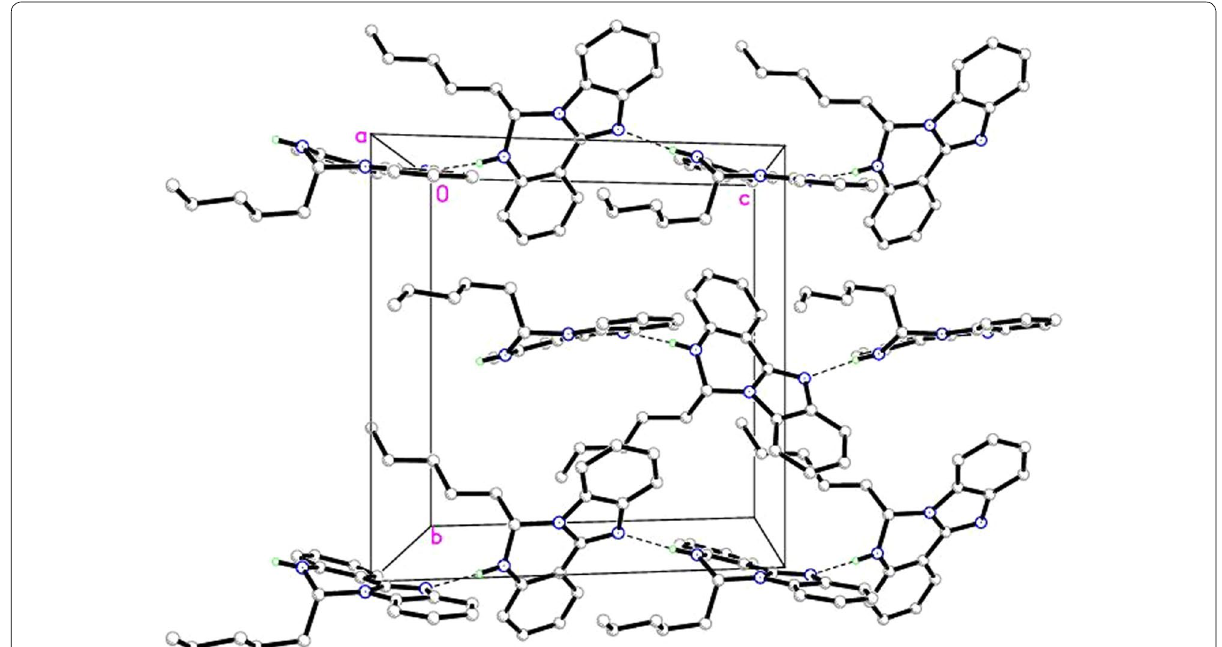
Fig. 11 Molecular packing of OCT compound viewed down a -axis. All hydrogen atoms except hydrogen bonded are omitted for